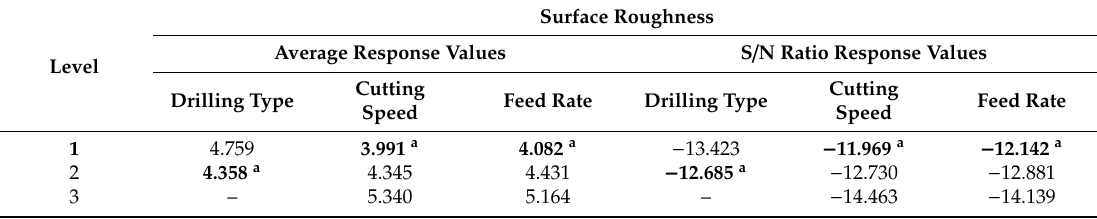
Table 5. Average response values and S / N ratios for surface